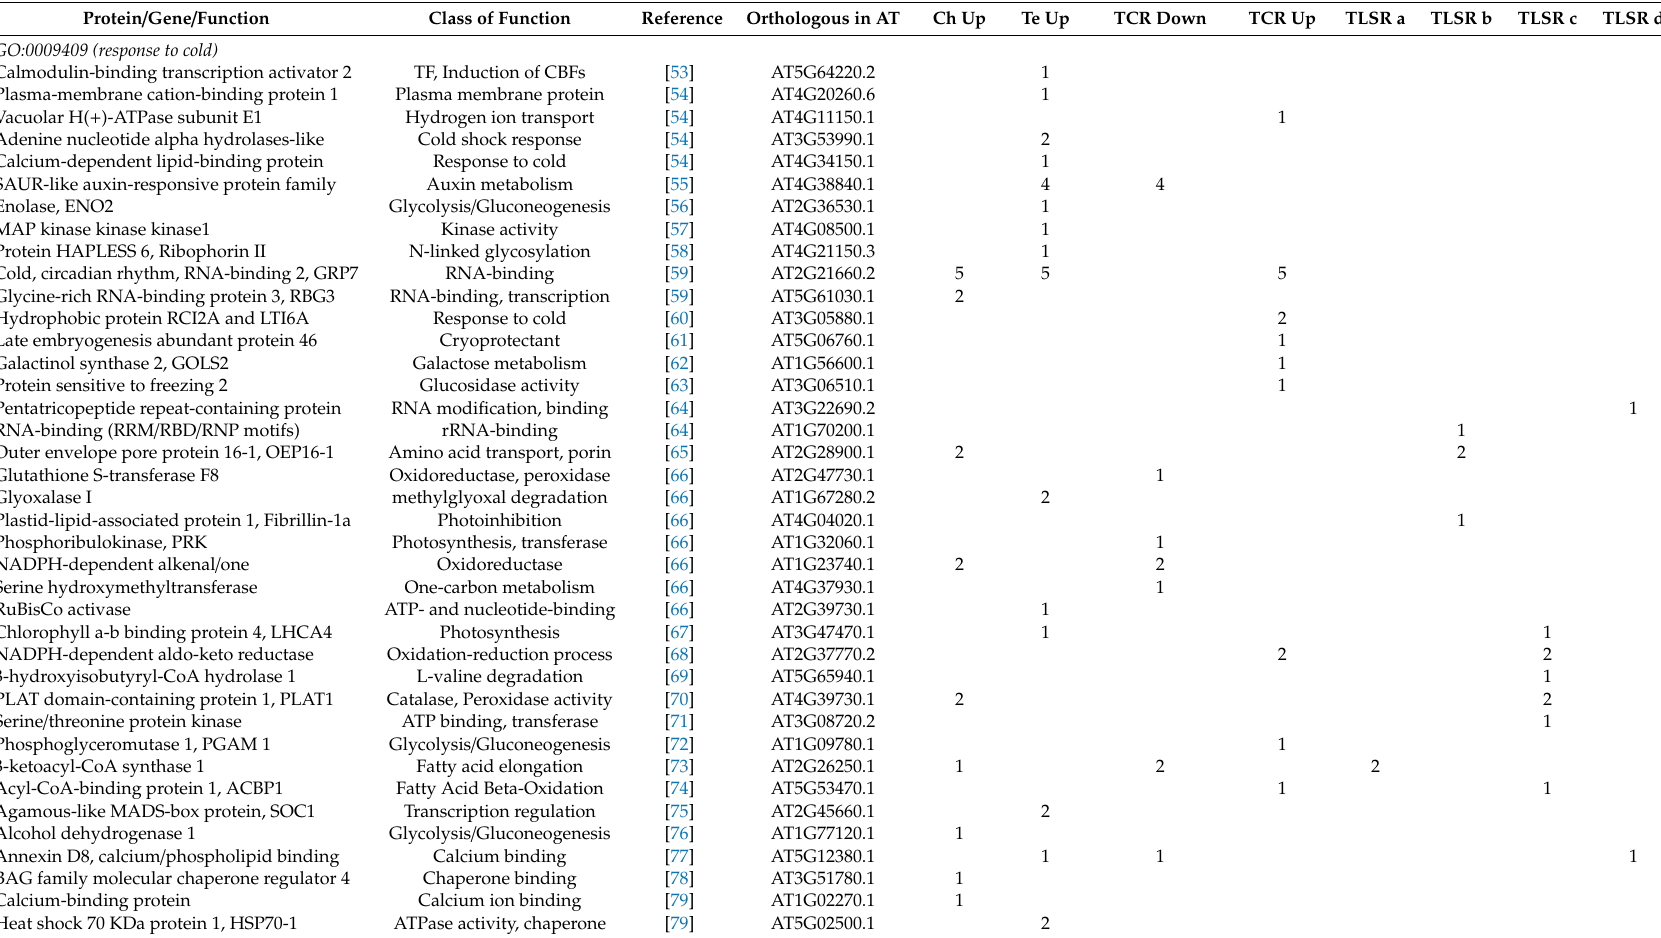
Table 2. GO matching of the cold response (i.e., “response to cold”, “cold acclimation”, “cellular response to cold”) in eight subsets of di ff erentially expressed genes. The Ch (Champagne) up and Te (T é r è se) up columns correspond to “LR”, followed by two columns of “TCR” down and up and the last four columns referring to the “TLSR” a, b, c, and d, as described in the legend of Figure